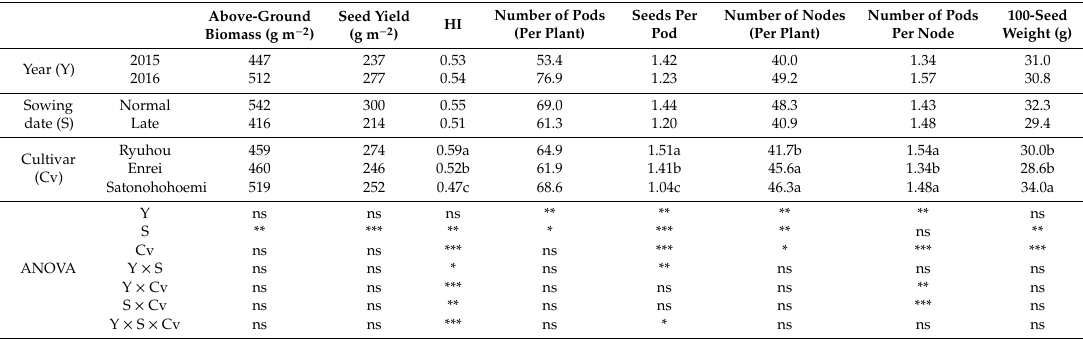
Table 2. Aboveground biomass (g m − 2 ), seed yield (g m − 2 ), harvest index (HI), and yield components (numbers of pods per plant, seeds per pod, nodes per plant, and pods per node, and 100-seed weight, g) of three soybean cultivars (Ryuhou, Enrei, Satonohohoemi) with normal and late sowing dates in 2015 and 2016 in the Tohoku region of northern